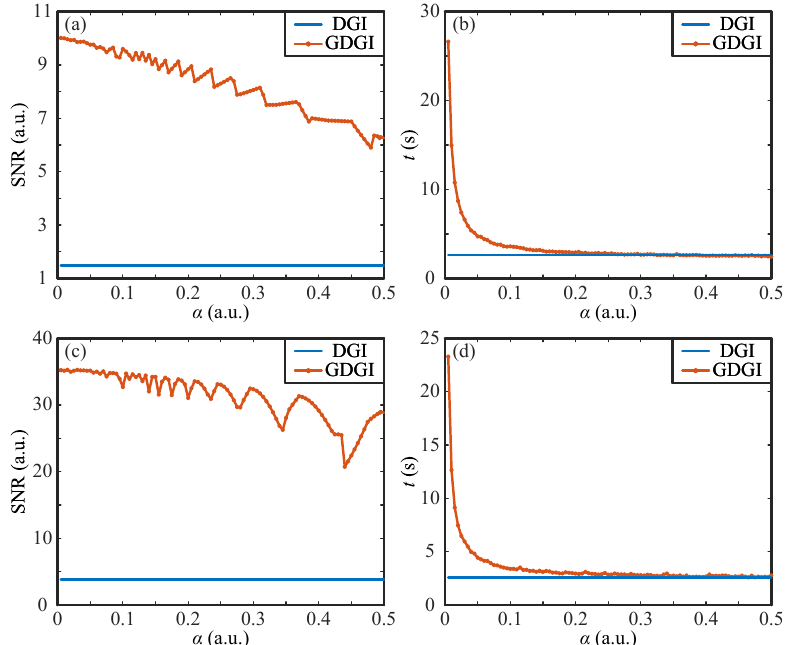
Figure 4. SNR and t curves as functions of the step size α . ( a , b ) and ( c , d ) are the curves for objects “01” and “02” by using the DGI and GDGI,